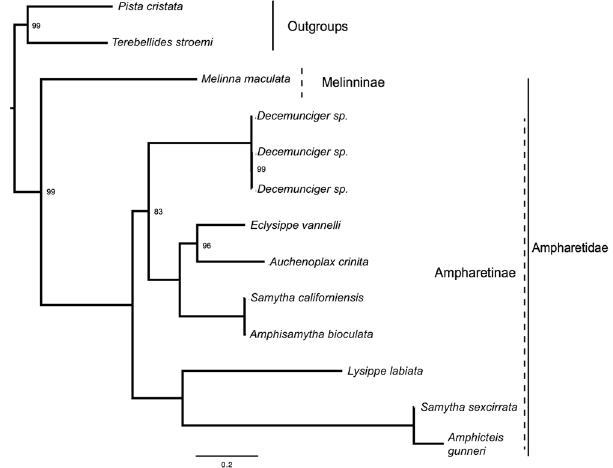
Figure 3. Maximum likelihood tree obtained when analyzing amino acid sequences from mtDNA protein coding genes. All nodes were supported with 100% bootstrap value (bs = 100) unless otherwise noted. Dashed lines indicate subfamilies represented within